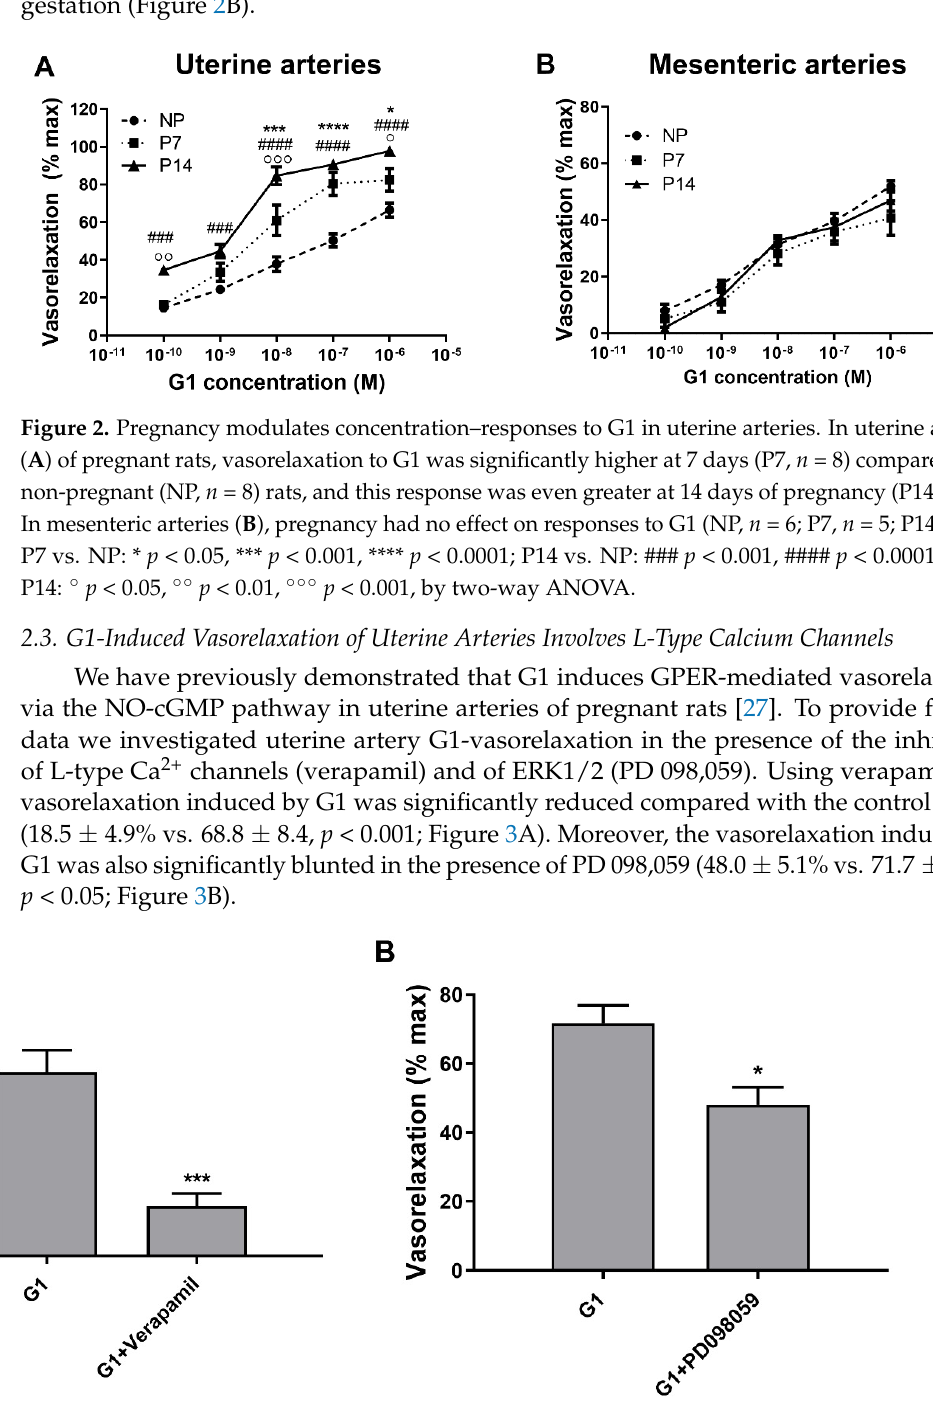
Figure 3. L ‐ type Ca 2+ channels and ERK1/2 signalling contribute to G1 ‐ mediated vasorelaxation. In uterine arteries, inhibition of L ‐ type calcium channels with verapamil (10 − 5 M, ( A )) and of ERK1/2 pathway with PD 098,059 (10 − 6 M, ( B )) significantly reduced vasorelaxation to G1 (10 − 8 M). *** p